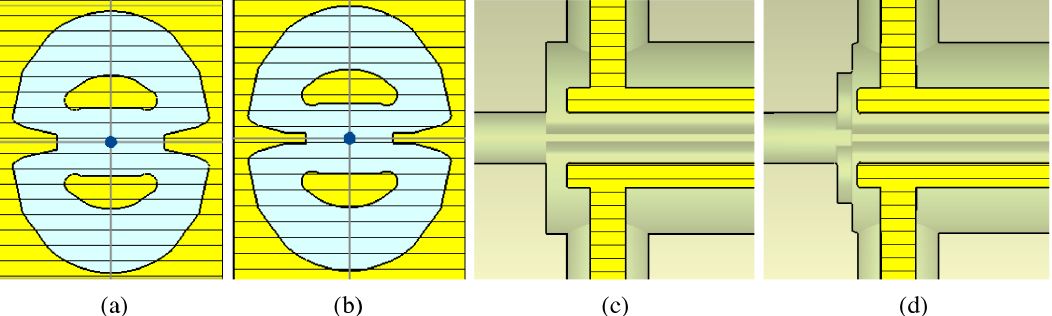
length.FIG. 6. Schematic view of the strategies used in the impedance optimizations. (a) and (b) show the transverse cross section of the kicker with wide and closer vanes, respectively. (c) and (d) show hard and smooth transition design of the endcover, respectively.